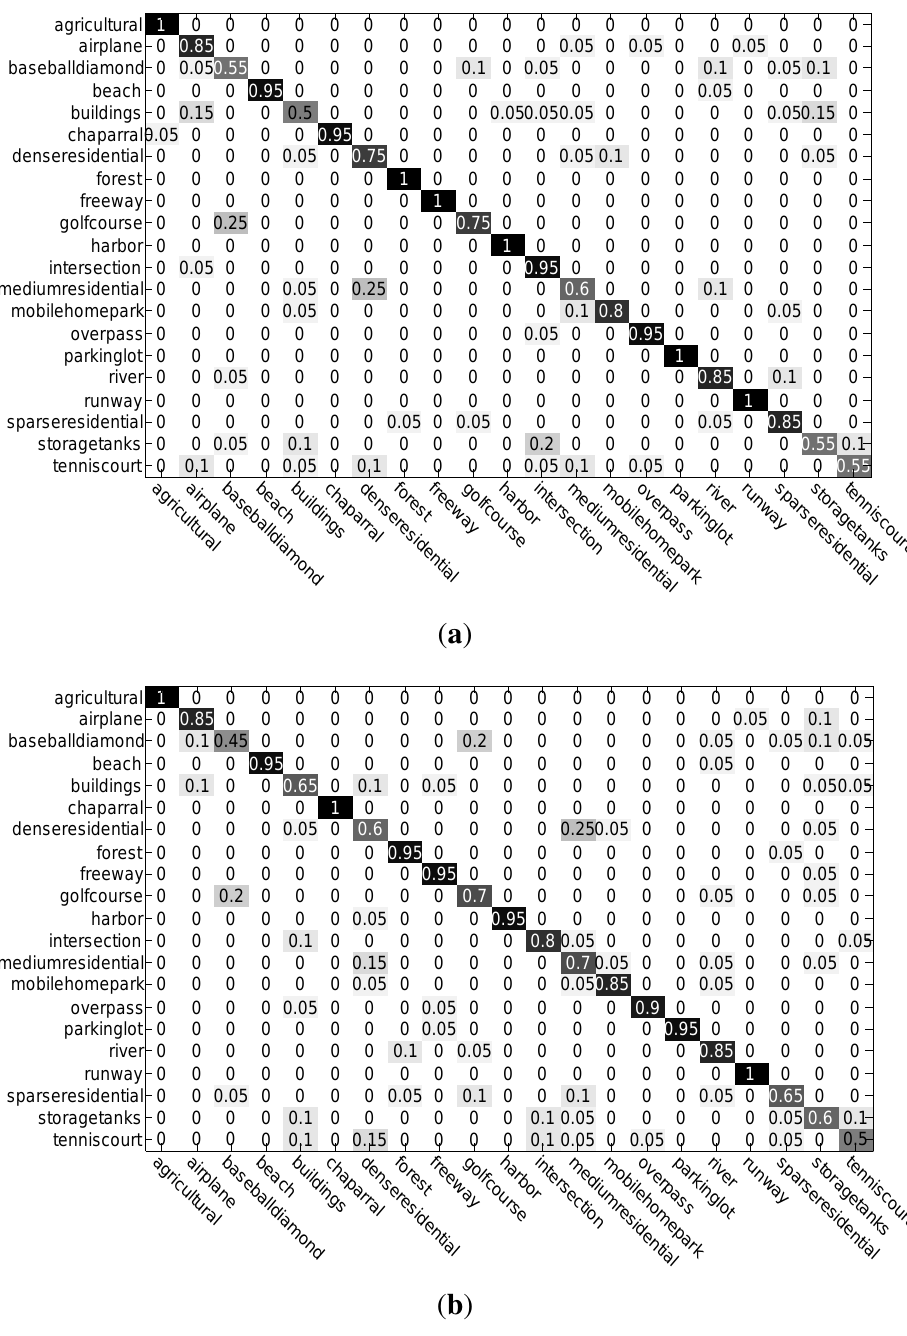
Figure 11. Comparisons of the confusion matrices using random sampling ( a ) and the SIFT sampling ( b ) method on the UC-Merced dataset when the sampling ratio is equal to 0 . 2